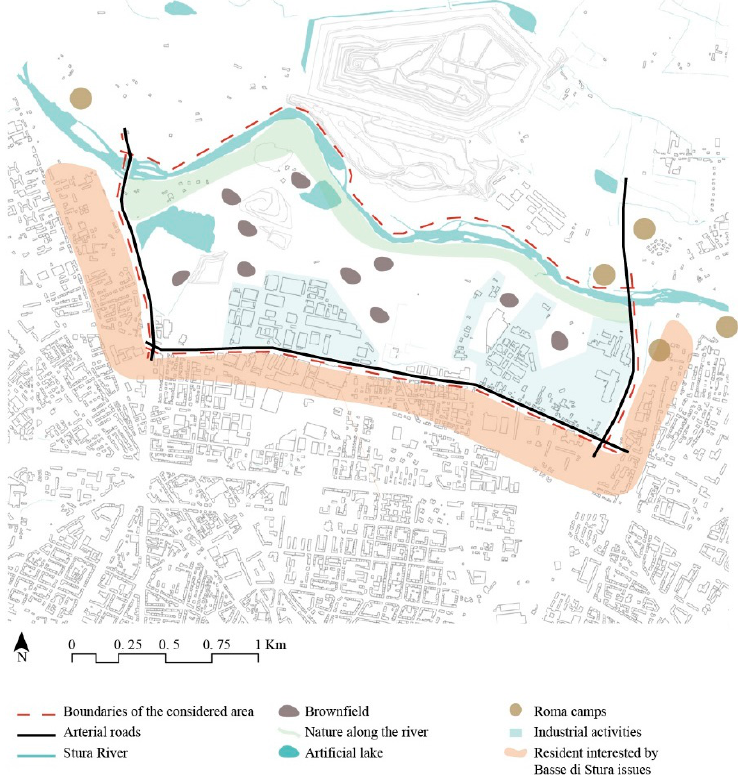
Figure 6. Main characteristics of Basse di Stura area (re-elaboration from Bottero et al., 2019).